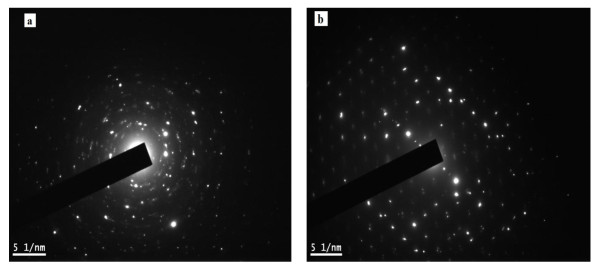
SAED patterns of (a) 0.0 and (b) 0.5 compositions of Ni0.7-xZnxCu0.3Fe2O4 ferrite nanoparticles.